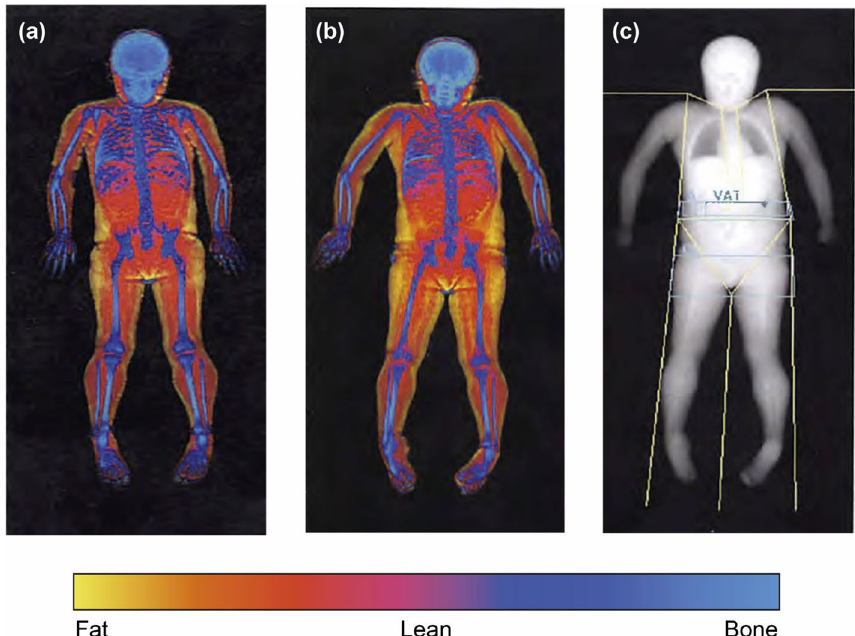
Figure 1. Representative DXA scan. A visual representation of fat mass, lean body mass and bone mass is shown for a participant ( a ) before treatment and ( b ) at the Week 49 visit. Cutlines are placed on the DXA scan to separate regions of interest for analysis ( c ). Primary regions for analysis included arms (left and right combined), legs (left and right combined), appendicular skeleton (arms and leg as a single region of interest) and total body excluding the head. Cutlines were placed by a trained analyst and reviewed by a radiologist prior to finalizing read results. DXA, Dual-energy X-ray